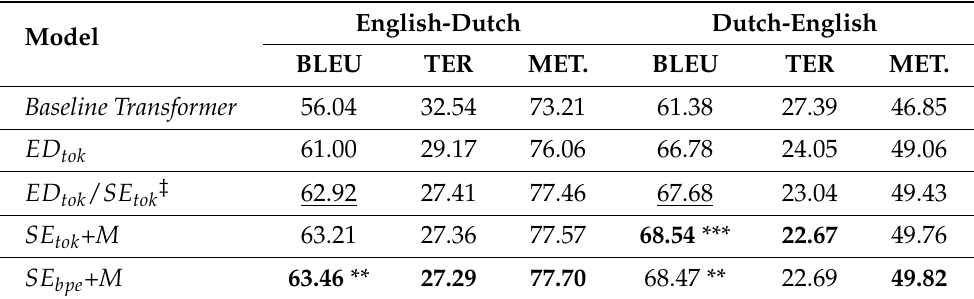
Table 6. Results for English ↔ Dutch. Statistical significance of the improvements in BLEU is tested against the strongest baseline scores, which are underlined (**: p < 0.01; ***: p < 0.001). Best scores for the tested systems are highlighted in